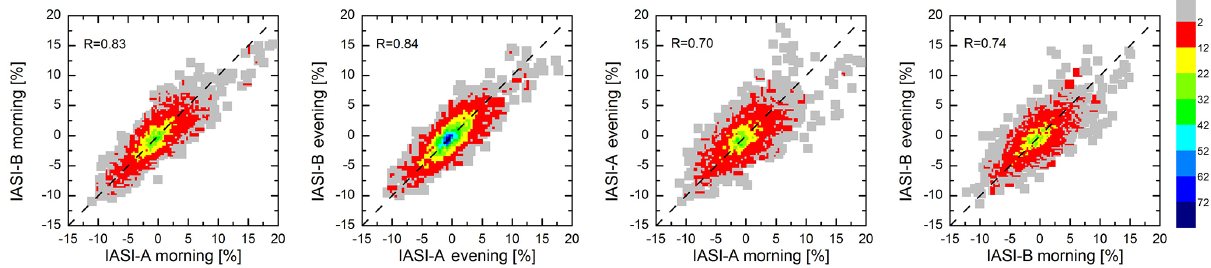
Figure 4. Scatter plots of the de-trended and de-seasonalised variability (in %) from the IASI-A and IASI-B overpasses (morning and evening) for O 3 . The legend shows the Pearson correlation coefficient, R , and the colour bar indicates the number of coincident data per bin. The dashed lines represent the diagonals ( x = y ).